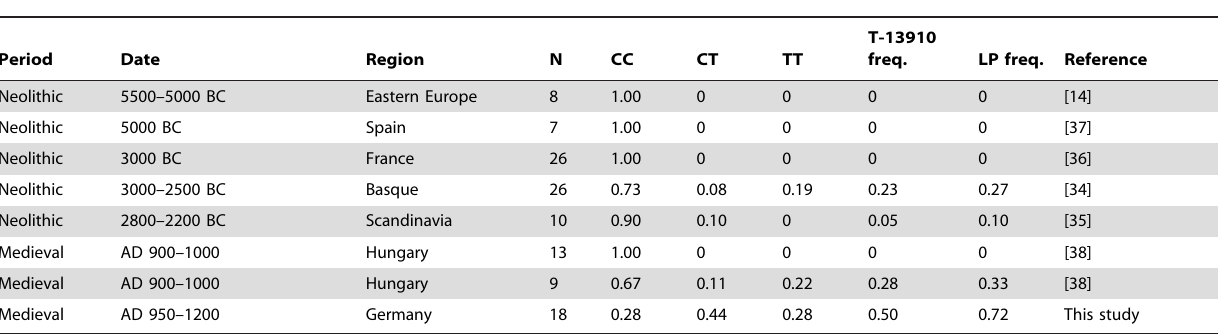
Table 3. Reported C/T-13910 genotype frequencies in ancient DNA studies.